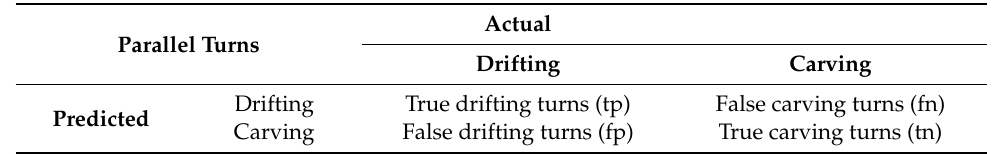
Table 1. Confusion matrix for parallel turns.